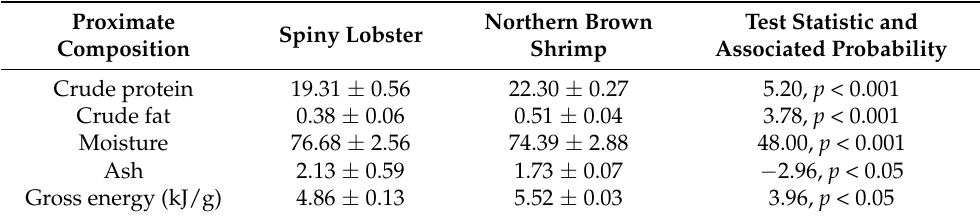
Table 1. Fillet proximate composition (percentage of wet weight) and statistical comparison (test statistic and associated p -value) of the European spiny lobster ( Palinurus elephas ) and northern brown shrimp ( Penaeus aztecus ). Data are means ± standard deviation ( n = 10).